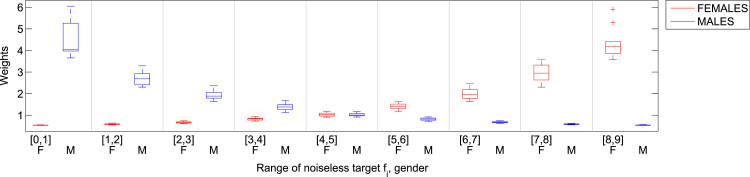
Here we show the weights that are estimated during the Instance Weighting procedure as the value of the noiseless target fi changes for each gender, for one of the biased samples from Tr2.